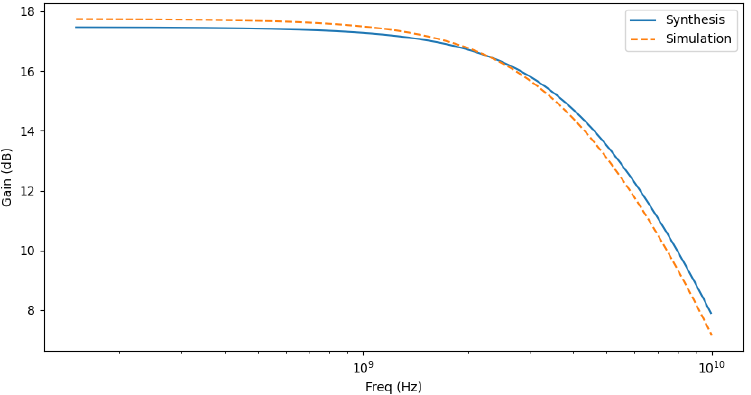
Figure 9. Gain (dB) vs. frequency (Hz) for the first design point nominal corner.